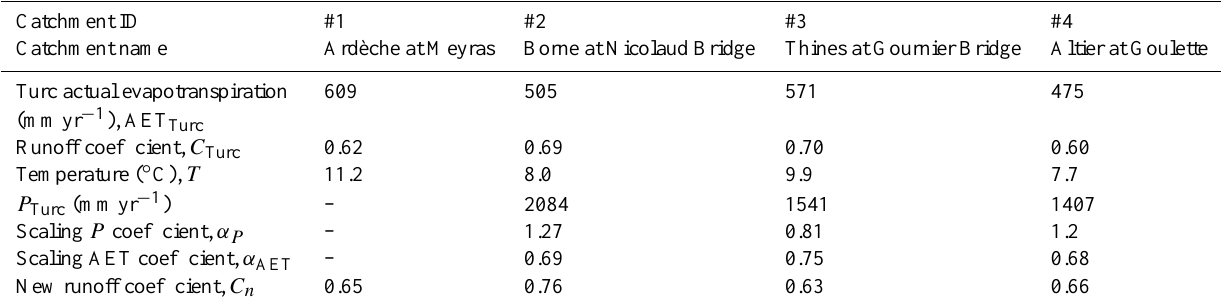
Table 4. Scaling hydro-climatic characteristics of the four examined Ardèche sub-catchments (2000–2008). Catchment ID